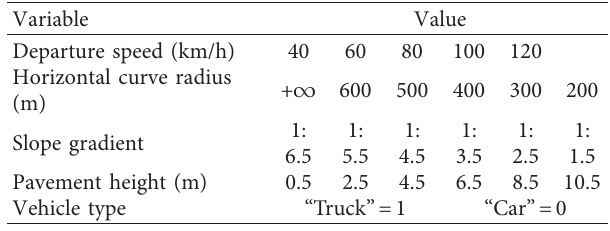
Table 2: Test variables.